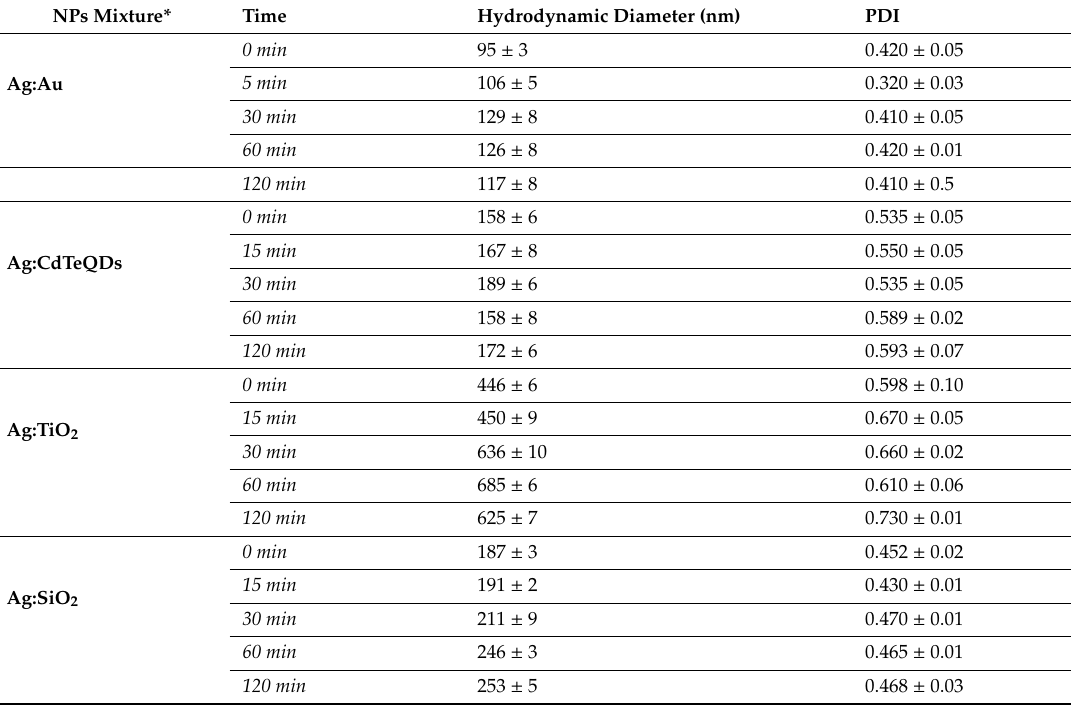
Table 3. Agglomeration of NP